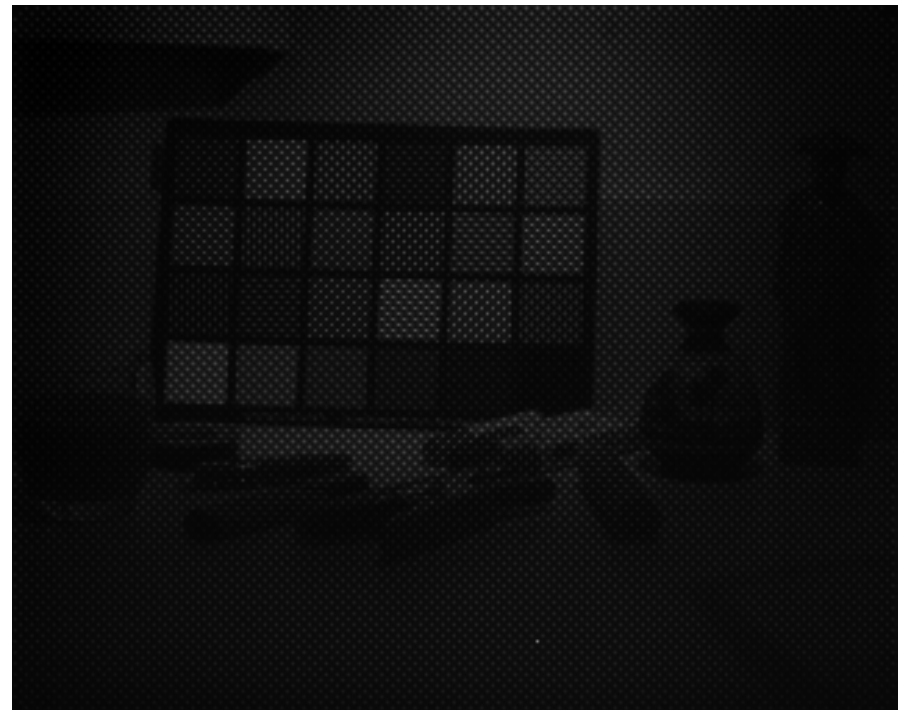
Figure 9. Raw image of scene 1 after applying the pre-processing described in Section